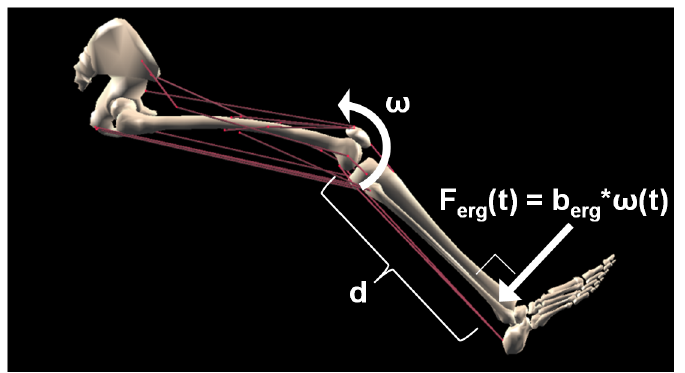
Fig 1. Schematic of dynamic knee extension model. In the experiment modeled [21, 22], subjects performed periodic knee extensions against different loads exerted by a cycle ergometer (see Figure 1 in [21]). A musculoskeletal model of the knee was constructed to model the motion actuated by the muscles crossing the knee as well as the corresponding energy consumed. A model of the cycle ergometer was also included (see text for details). Graphic of musculoskeletal model is a screenshot of the model we constructed in open-source software named MusculoSkeletal Modeling Software (MSMS; [27]).